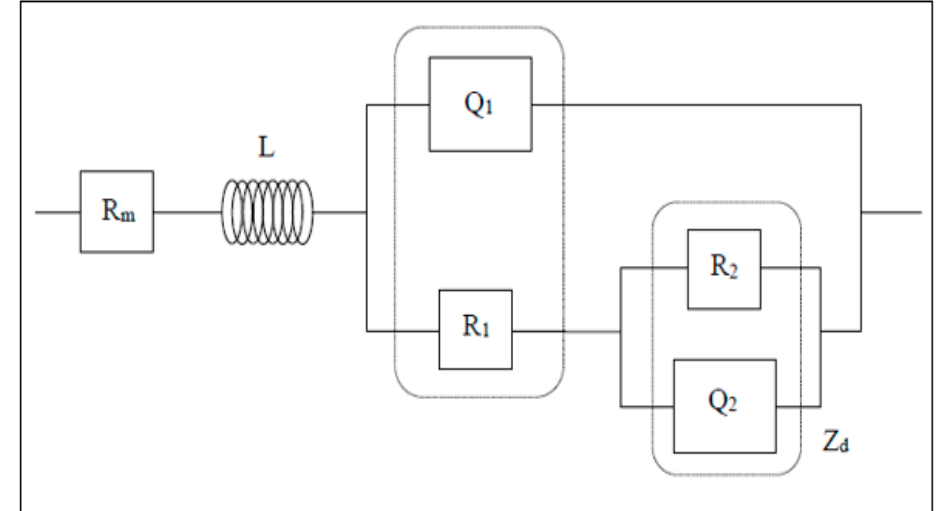
Figure 8. Complex impedance spectra for the three-humidification degree of the PEMFC. The equivalent circuit to extract the data is shown in Figure 9.